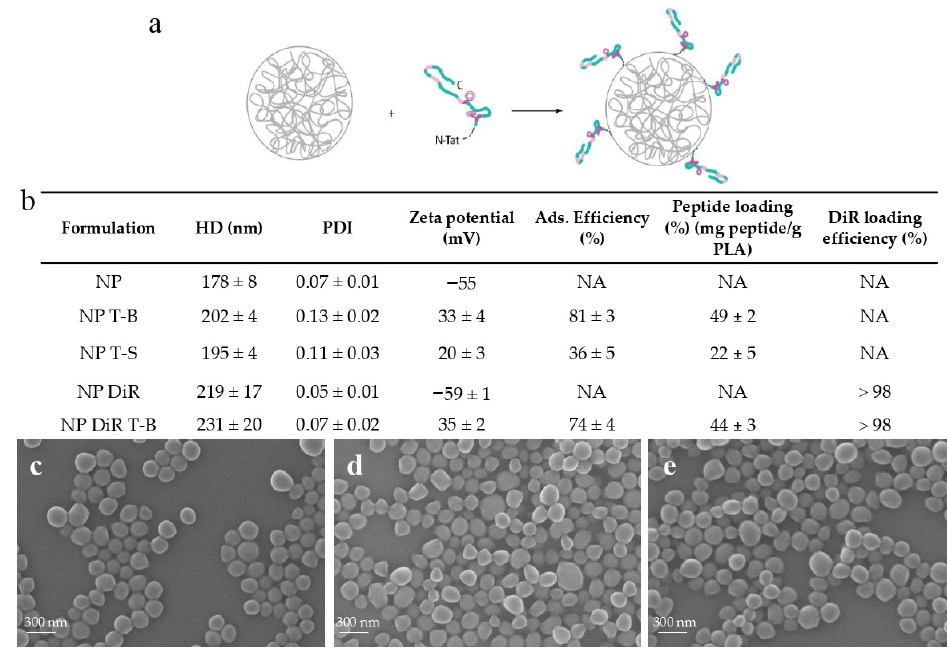
Figure 1. Physicochemical characteristics and morphology of peptide formulations based on PLA particles . ( a ) The Tat-Beclin (T-B) peptide or Tat-Scrambled (T-S) control peptide was adsorbed on biodegradable particles (NP) or fluorescent particles (NP DiR), made of poly(L-Lactide)/Poly(D-Lactide). ( b ) Hydrodynamic diameter (HD) (Z-average), polydispersity index (PDI), zeta potential, adsorption efficiency, peptide loading and DiR encapsulation efficiency of the prepared formulations. Values are means ± SD of three measurements pooled from at least three independent experiments. SEM micrographs of plain particles (NP) ( c ), Tat-Beclin particles (NP T-B) ( d ) and Tat-Scrambled peptide control particles (NP T-S) ( e ). Scale bar: 300 nm.